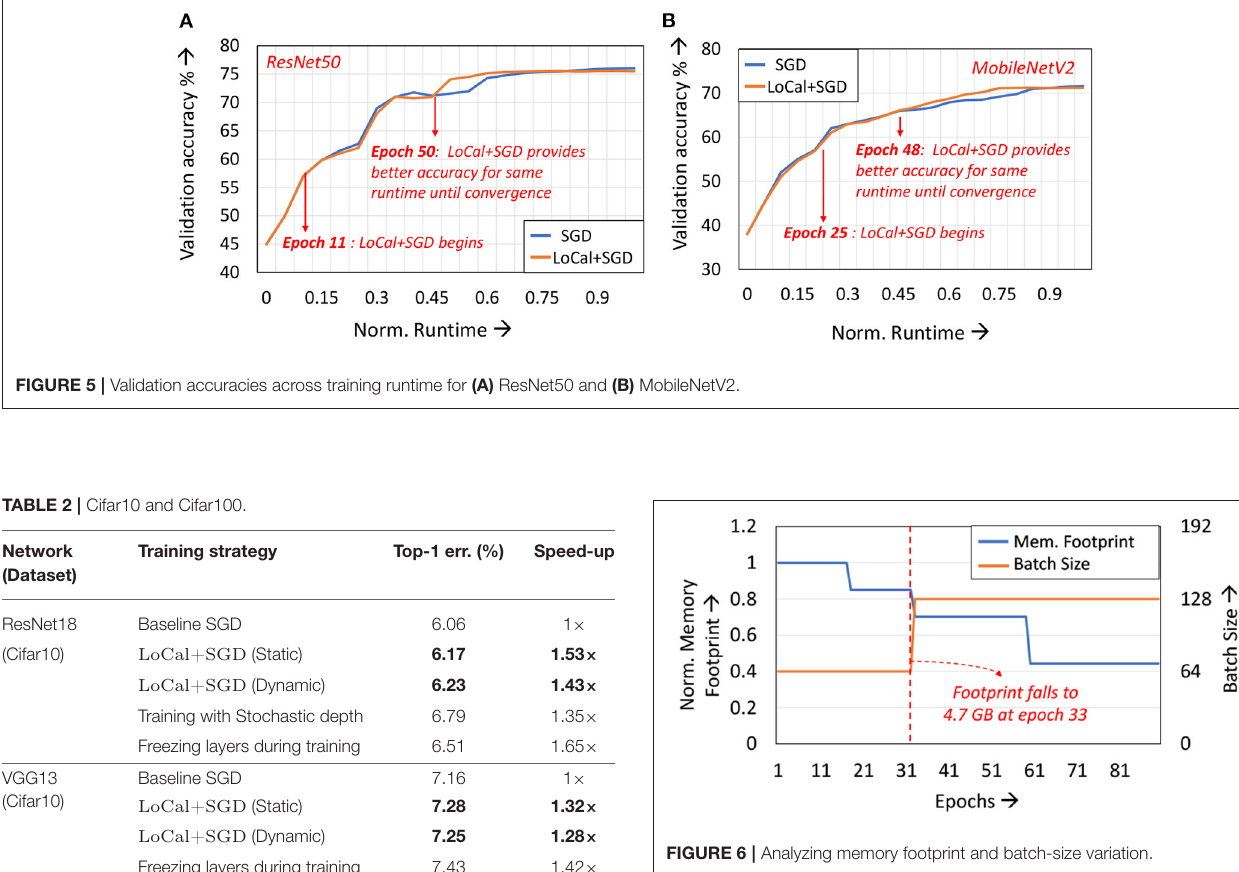
FIGURE 6 | Analyzing memory footprint and batch-size variation.